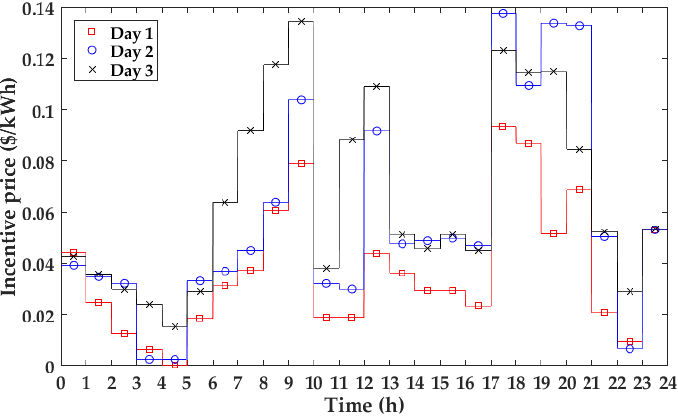
Figure 10. Sums of incentive prices and TOU prices.